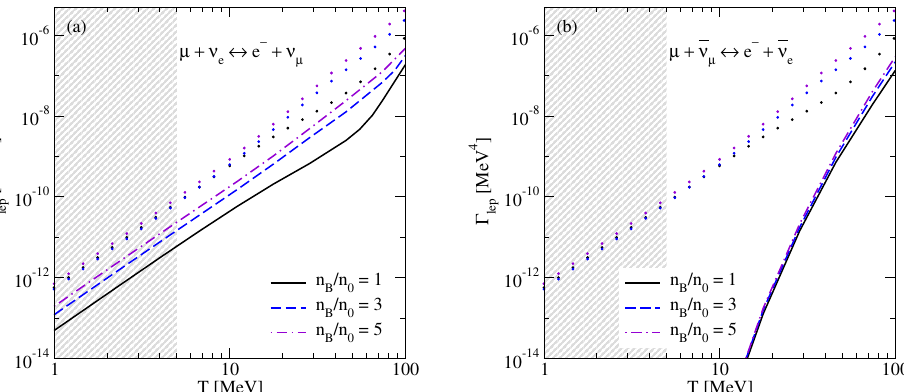
Figure 5. Rates of the neutrino ( a ) and antineutrino ( b ) absorption processes as functions of the temperature for different values of the density for the neutrino-trapped matter. The electron (Urca) capture rates are shown by dotted lines for comparison; the muon capture rates are slightly higher than the electron capture rates and are not shown. The shaded areas show the neutrino transparent region of temperatures T ≤ 5